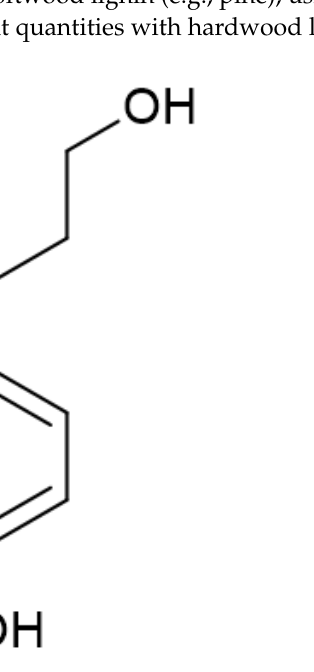
Figure 1. Chemical structure of the lignin-derived monomer dihydroconiferyl alcohol (DCA). For their application as antioxidant additives in hydrophobic matrixes such as cos- metics, oils or polymers, lignin-derived phenols need to be lipophilized to ensure good compatibility. This can be achieved by esterifying aliphatic chains into some of the hy- droxyl groups, preferably preserving the aromatic -OHs responsible for their antioxidant